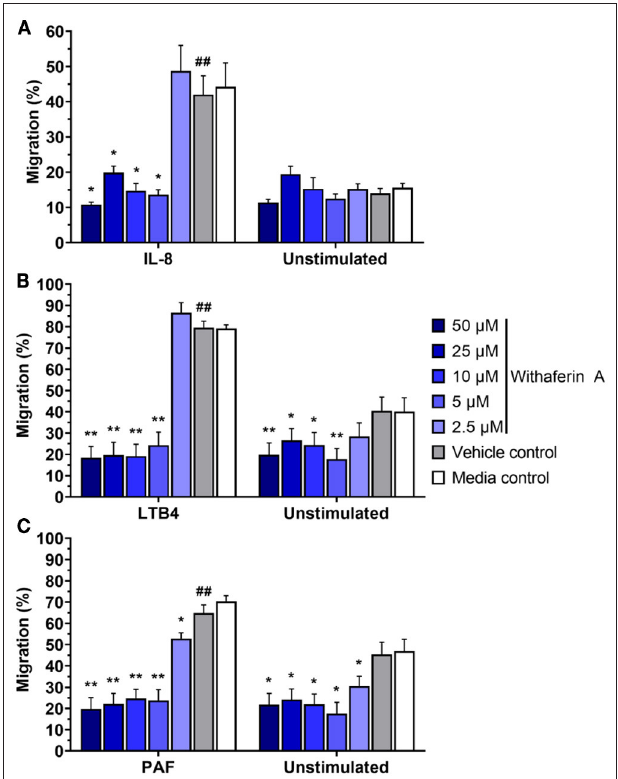
FIGURE 2 | Withaferin A inhibits neutrophil migration toward IL-8, LTB4, and PAF. Mean (SEM) percent migration of treated equine neutrophils toward IL-8 [ (A) n = 5 horses], LTB4 [ (B) n = 4 horses], or PAF [ (C) n = 4 horses]. Fluorescent detection of calcein AM-loaded neutrophils relative to 100% migration control wells. One-tailed paired t-test of VC neutrophils; ## p < 0.01 compared to unstimulated VC. One-way repeated measures ANOVA (Holm-Sidak multiple comparison testing); * p < 0.05, ** p < 0.01, as compared to VC within same stimulation condition.